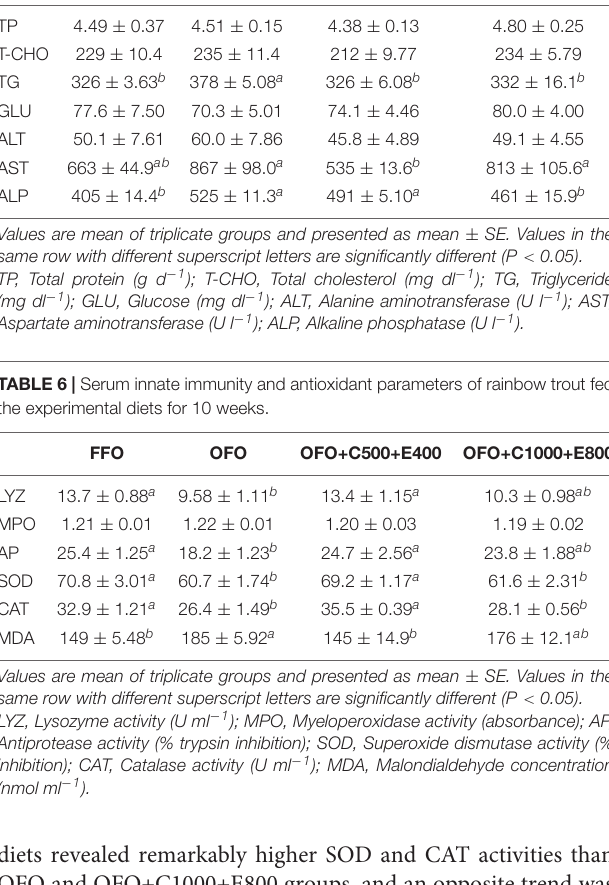
Values are mean of triplicate groups and presented as mean ± SE. Values in the same row with different superscript letters are significantly different (P <